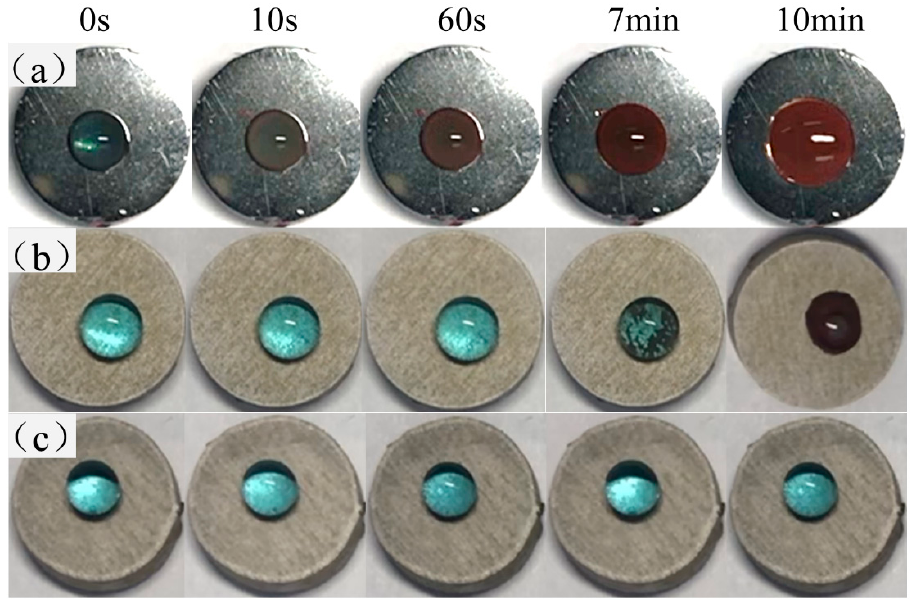
Figure 8. Sequential images of a highly corrosive liquid droplet (pH = 1 HCl + CuSO 4 ) on the surfaces of untreated Q235 carbon steel ( a ), structured Q235 carbon steel ( b ), superhydrophobic Q235 carbon steel ( c ).